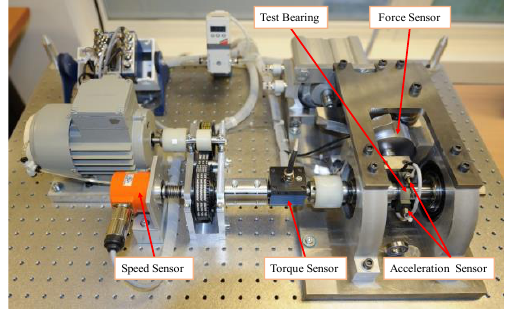
Figure 8. PRONOSTIA test platform [44]. Table 1. Description of working conditions of PHM challenge 2012 bearing dataset.